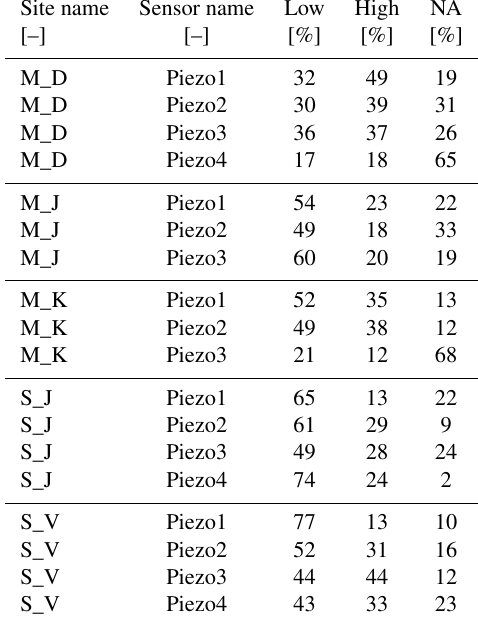
Table 3. Fractions of events below (low, including partial and dry events) and above (high) the threshold. All other event types ( lowAmplitudes , noLocalMaximum , allNA ) are considered